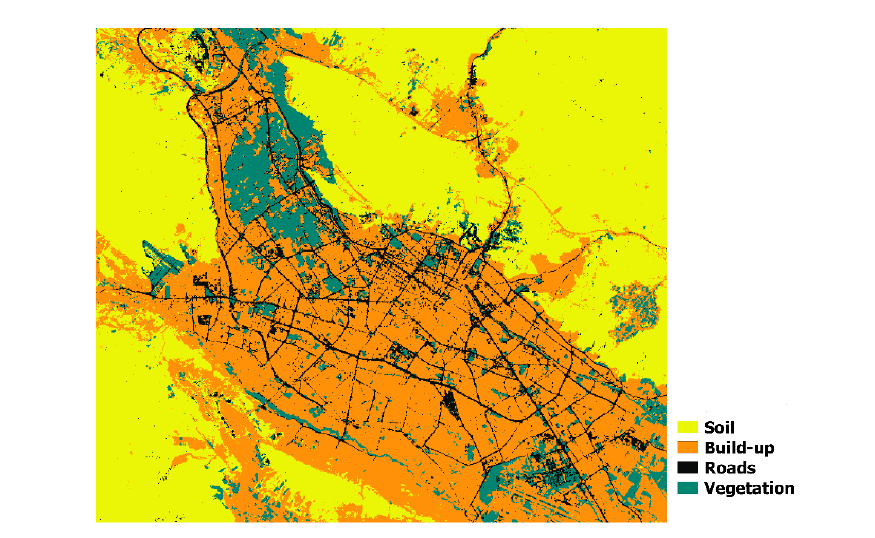
Figure 5. Image classification using ML classification technique with semi-automatic classification plug-in developed by Luca